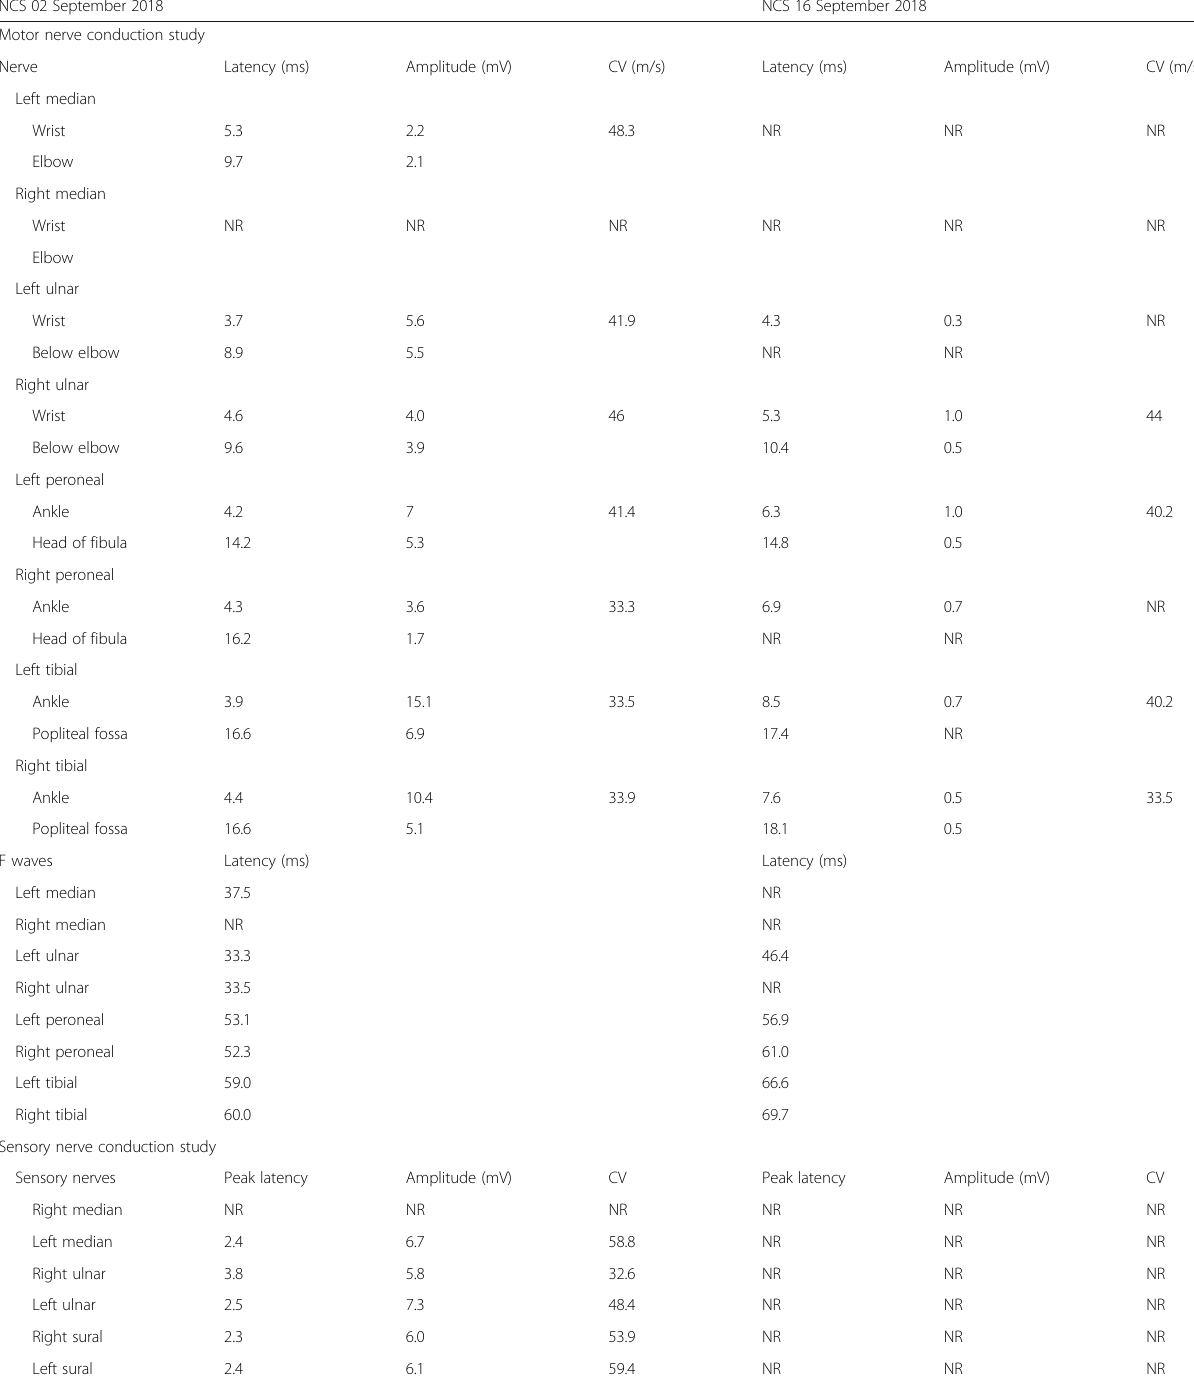
Table 1 Nerve conduction studies